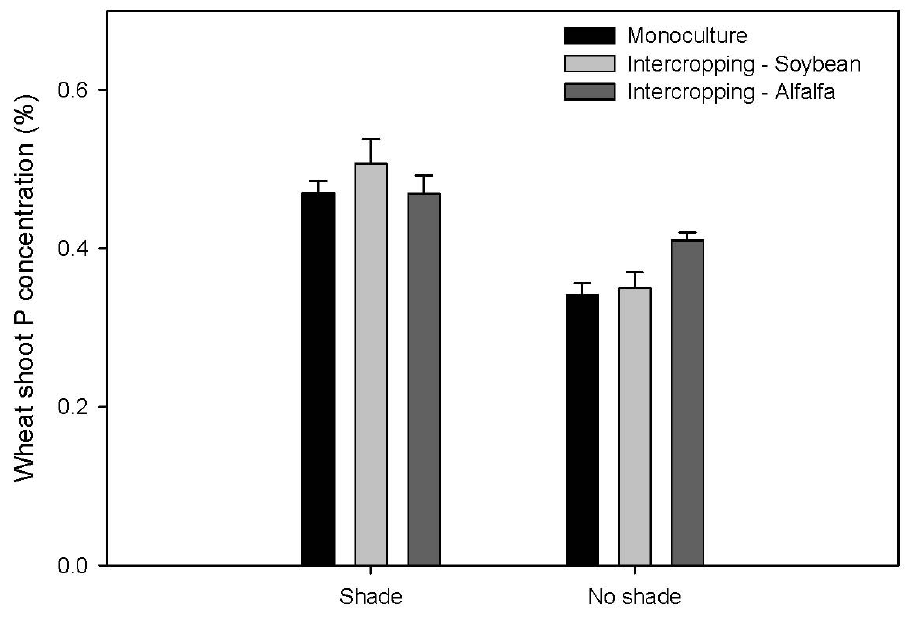
Figure 3. Phosphorus concentration (%) of wheat shoots for monocropped wheat and wheat intercropped with soybean and alfalfa under shade and no shade. Bars represent SE of the means (N=3).